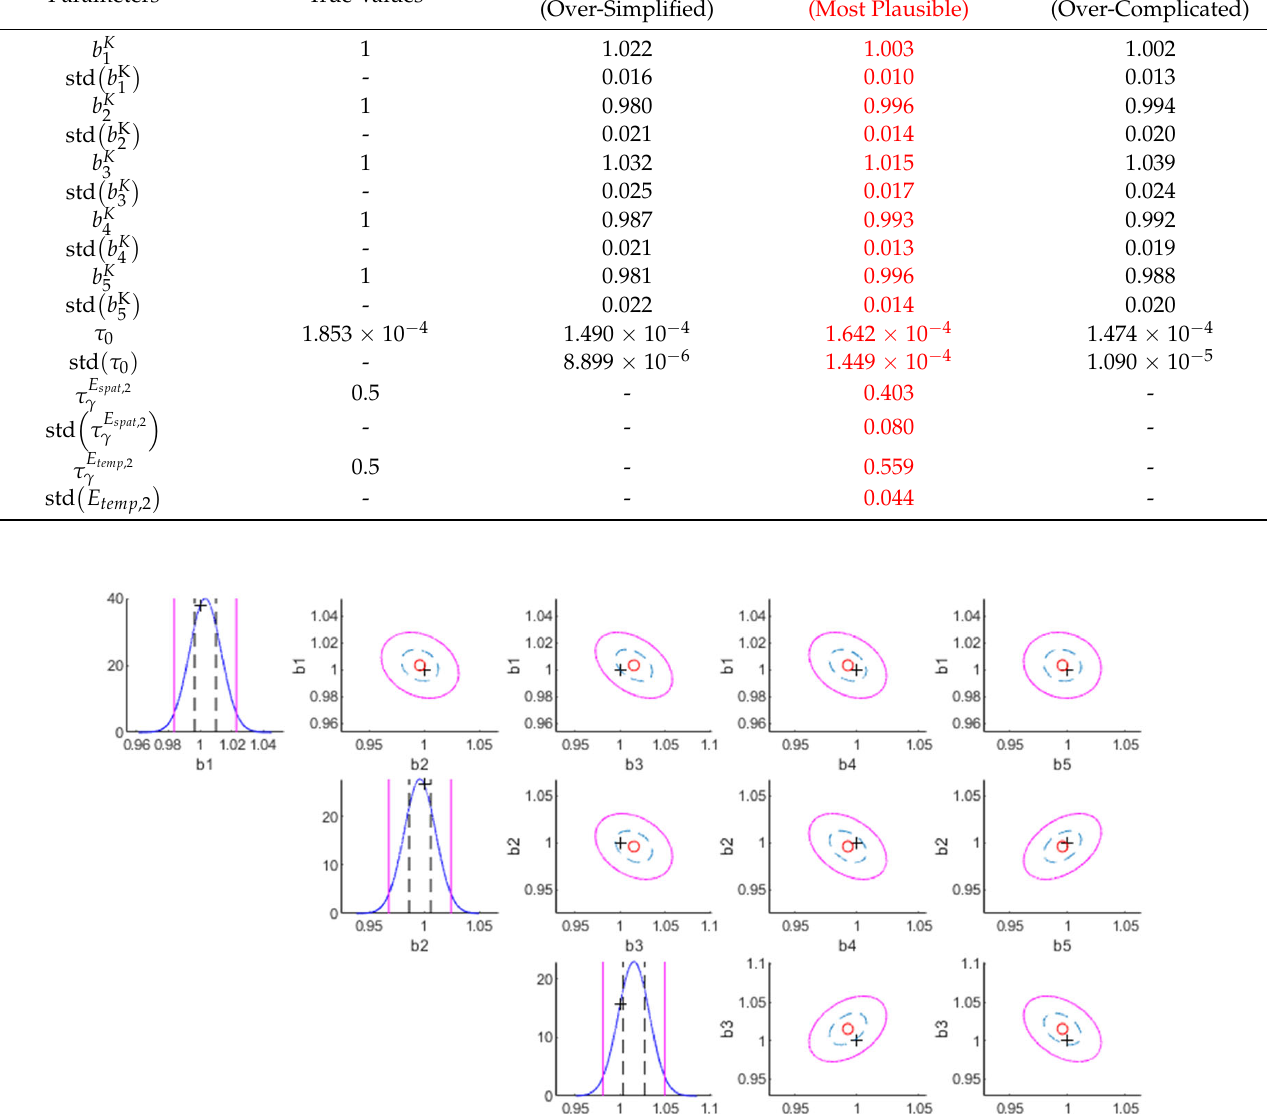
Table 3. Parameter identification results (no damage case).